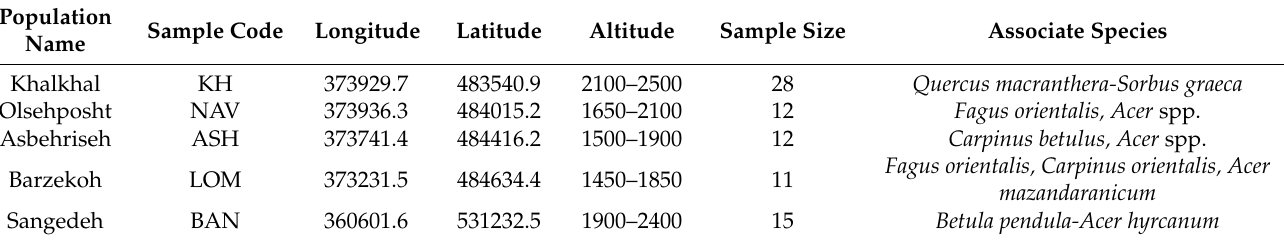
Table 1. Geographical characteristics of the studied